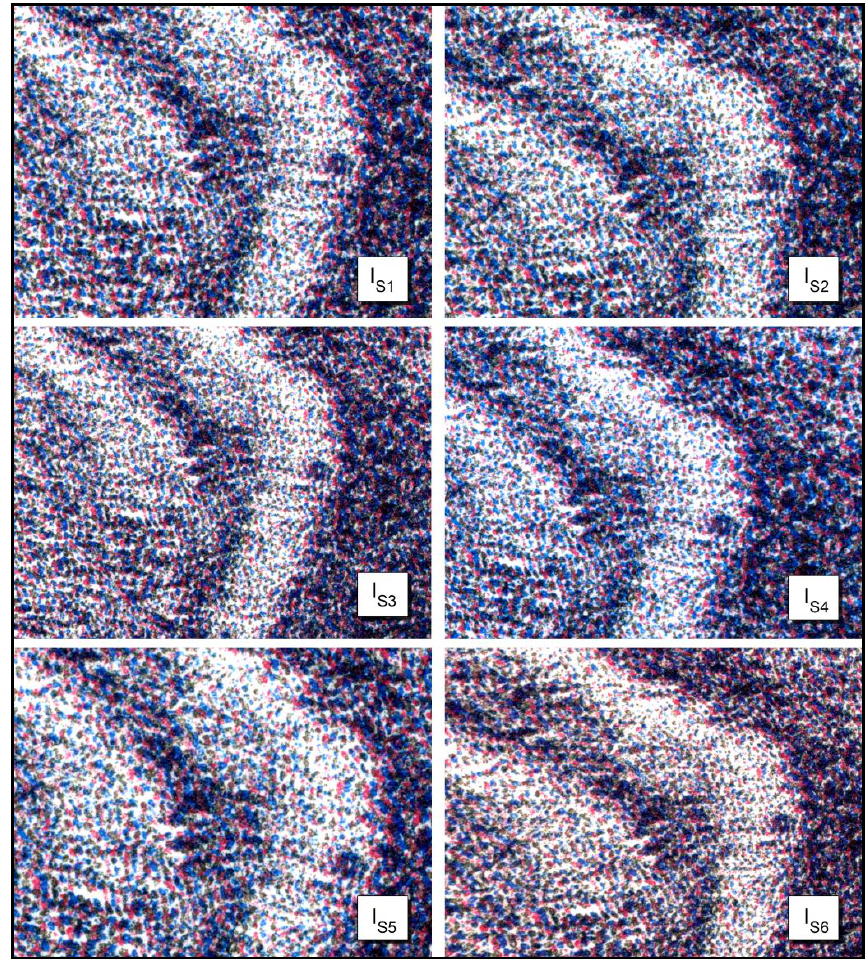
Figure 11. Job’s lithograph captured under different illumination conditions (particular of Dog 18/20).